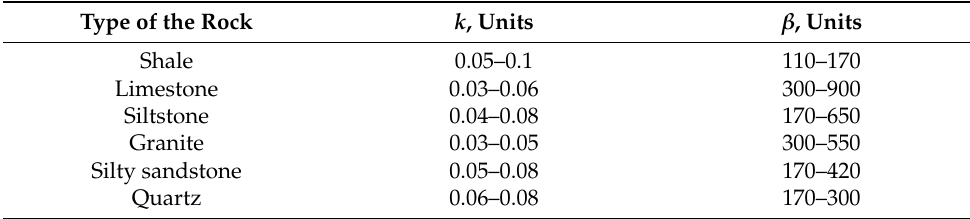
Table 2. The values of the coefficients depending on the type of rock. Type of the Rock k , Units